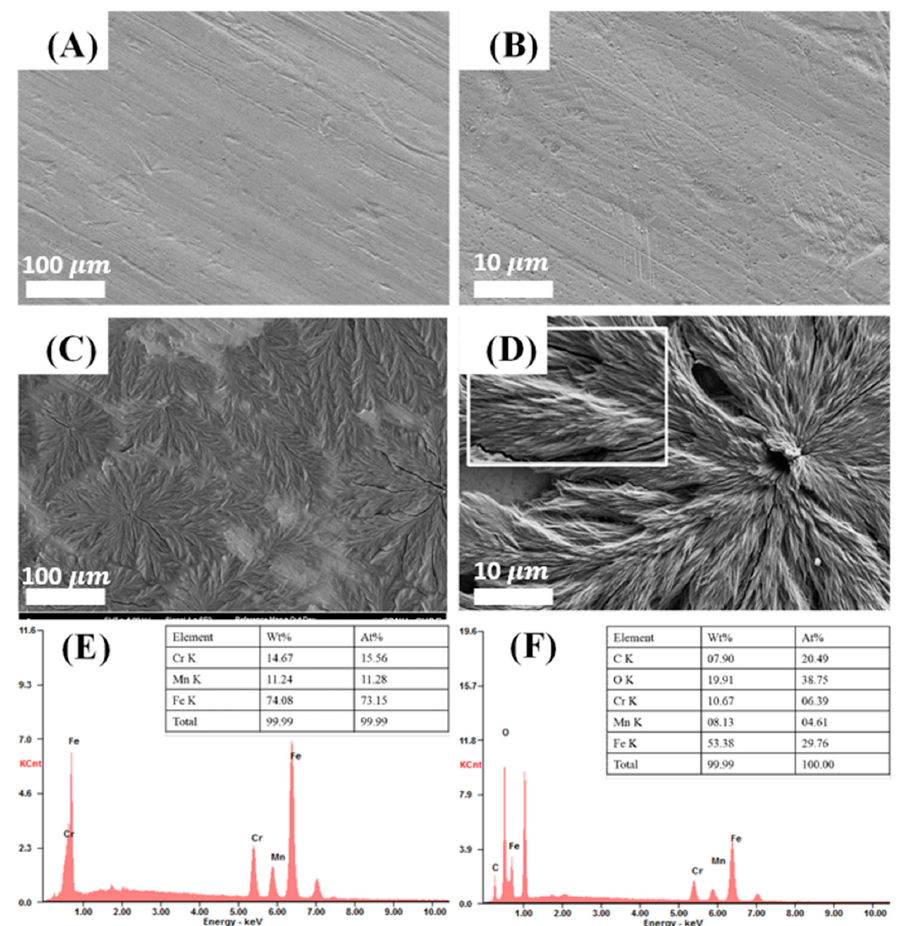
Figure 2. ( A – D ) Field emission scanning electron microscopy (FESEM) images in two magnitudes (×1000, 5000) of stainless steel substrates with/without polycaffeic acid coating. Energy dispersive X-ray spectroscopy (EDS) spectra showing the main components present on the surface of ( E ) etched stainless steel 316L and ( F ) stainless steel 316L coated with polycaffeic